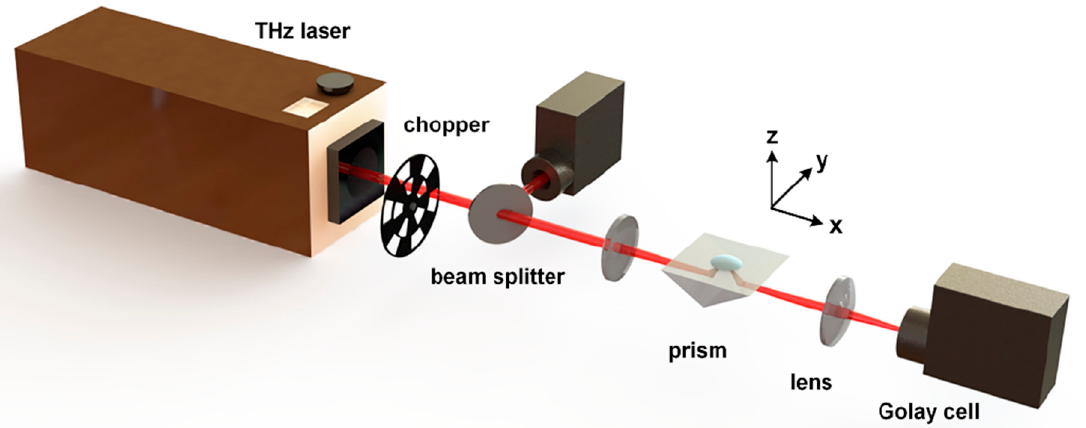
Figure 6. The setup of the vertically scanning imaging system. Reproduced with permission from [76], Copyright © 2018, The Optical Society.